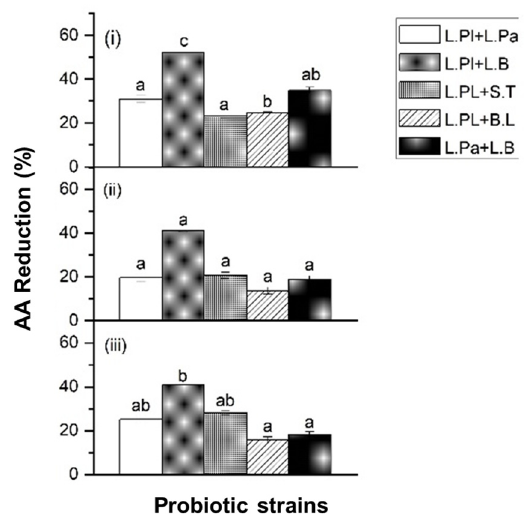
Figure 3. The acrylamide (AA) reduction ability of five formulas of probiotic bacteria: Lactiplan- tibacillus plantarum ATCC14917 (50%) + Lacticaseibacillus paracasei ATCC25302 (50%) ( L. Pl. + L. Pa. ), Lactiplantibacillus plantarum ATCC14917 (50%) + Lactobacillus bulgaricus ATCC11842 (50%) ( L. Pl. + L. B. ), Lactiplantibacillus plantarum ATCC14917 (50%) + Streptococcus thermophilus ATCC19258 (50%) ( L. Pl. + S. T. ), Lactiplantibacillus plantarum ATCC14917 (50%) + Bifidobacterium longum ATCC15707 (50%) ( L. Pl. + B. L. ), and Lacticaseibacillus paracasei ATCC25302 (50%) + Lactobacillus bulgaricus ATCC11842 (50%) ( L. Pa. + L. B. ), when exposed to ( i ) 350 ng/mL, ( ii ) 750 ng/mL, and ( iii ) 1250 ng/mL AA solu- tions. Probiotic concentration was 10 8 CFU/mL. Incubated at 37 °C for 4 h at pH 6.5–7.0. Expressed as AA reduction percentage. Different characters in the same panel indicate significant differences, whereas the same character indicates not significant.